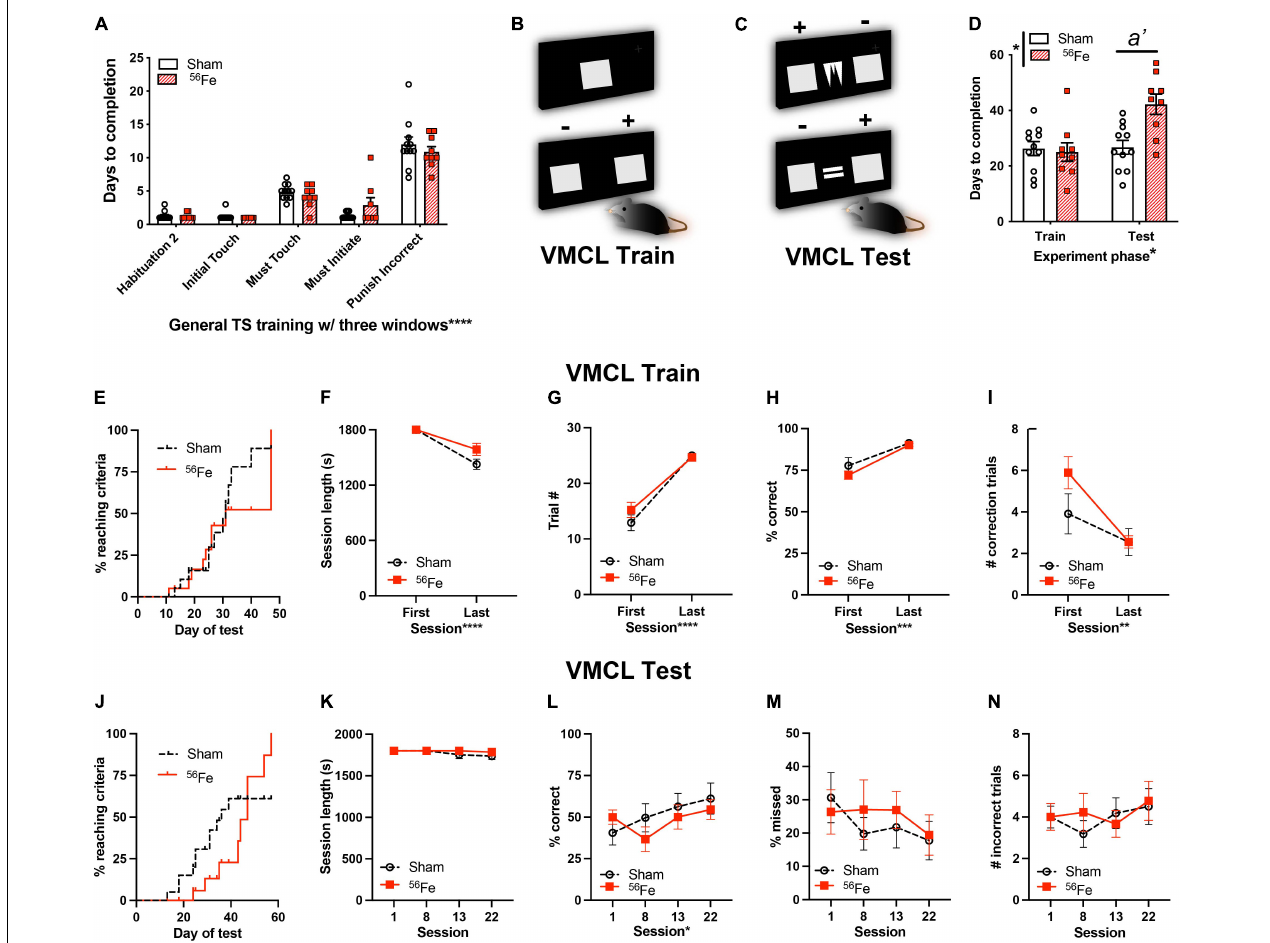
FIGURE 5 | Six-month-old female mice exposed to whole-body 56 Fe IRR perform worse than Sham in tests of stimulus-response habit learning. (A) Sham and 56 Fe IRR groups performed similarly in each of the five steps of general touchscreen training with three windows: Habituation 2, Initial Touch, Must Touch, Must Initiate, and Punish Incorrect. (B) Schematic of the single, large lit square image (top) and two, large lit squares used for Visuomotor Conditional Learning (VMCL) Train. The mouse learns that touching one square (+) is rewarded while the other (-) is not rewarded. (C) Schematic of the two, large lit squares flanking samples used for VMCL Test. The mouse learns that touching one square (+) is rewarded while the other (-) is not rewarded depending on the center image shown. (D) 56 Fe IRR mice took a similar number of days to complete VMCL Train - but took more days to complete the VMCL Test - compared to Sham mice. (E) Cumulative